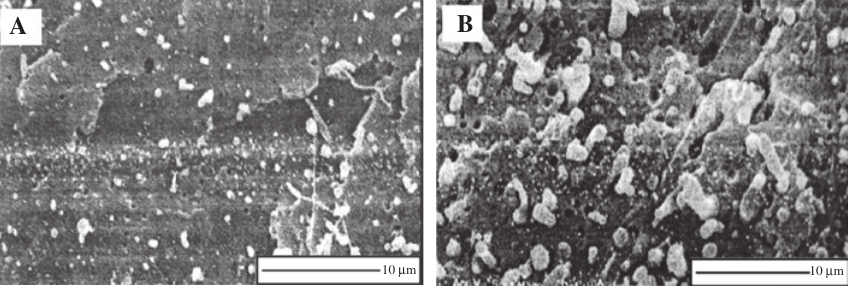
Figure 2: SEM micrographs of cryofractured surfaces of PP/PC blends. (A) Blend with 10 wt% PC, (B) blend with 30 wt% PC.